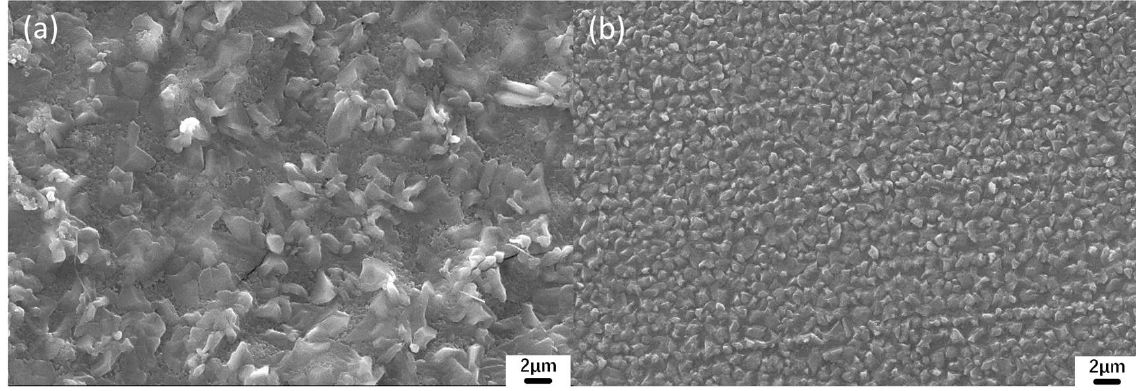
Figure 9. SEM images of ( a ) GNs film, ( b ) TiO 2 /GNs film.